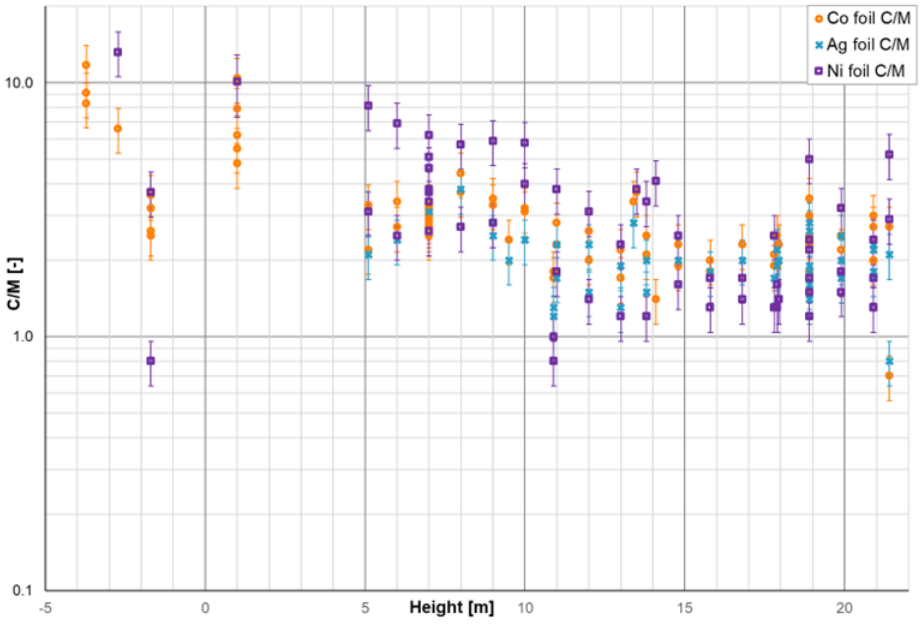
Figure 3. Flux Validation Results (C/M-values) plotted against reactor building height